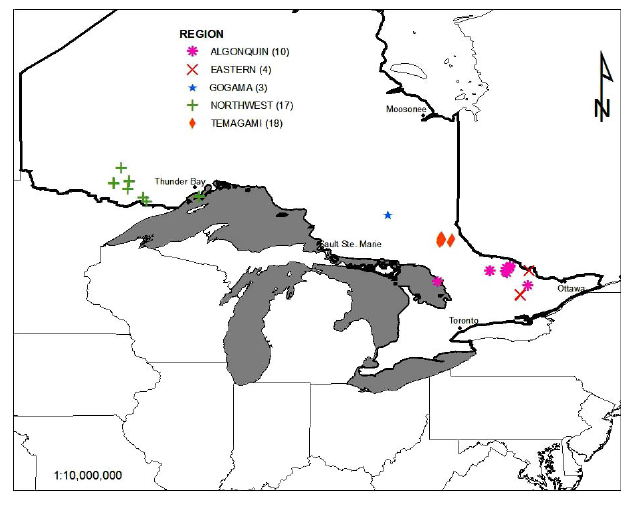
Fig. 1 . Map of pine stand locations in five regions in the province of Ontario, Canada: Algonquin, Eastern, Gogama, Northwestern, and